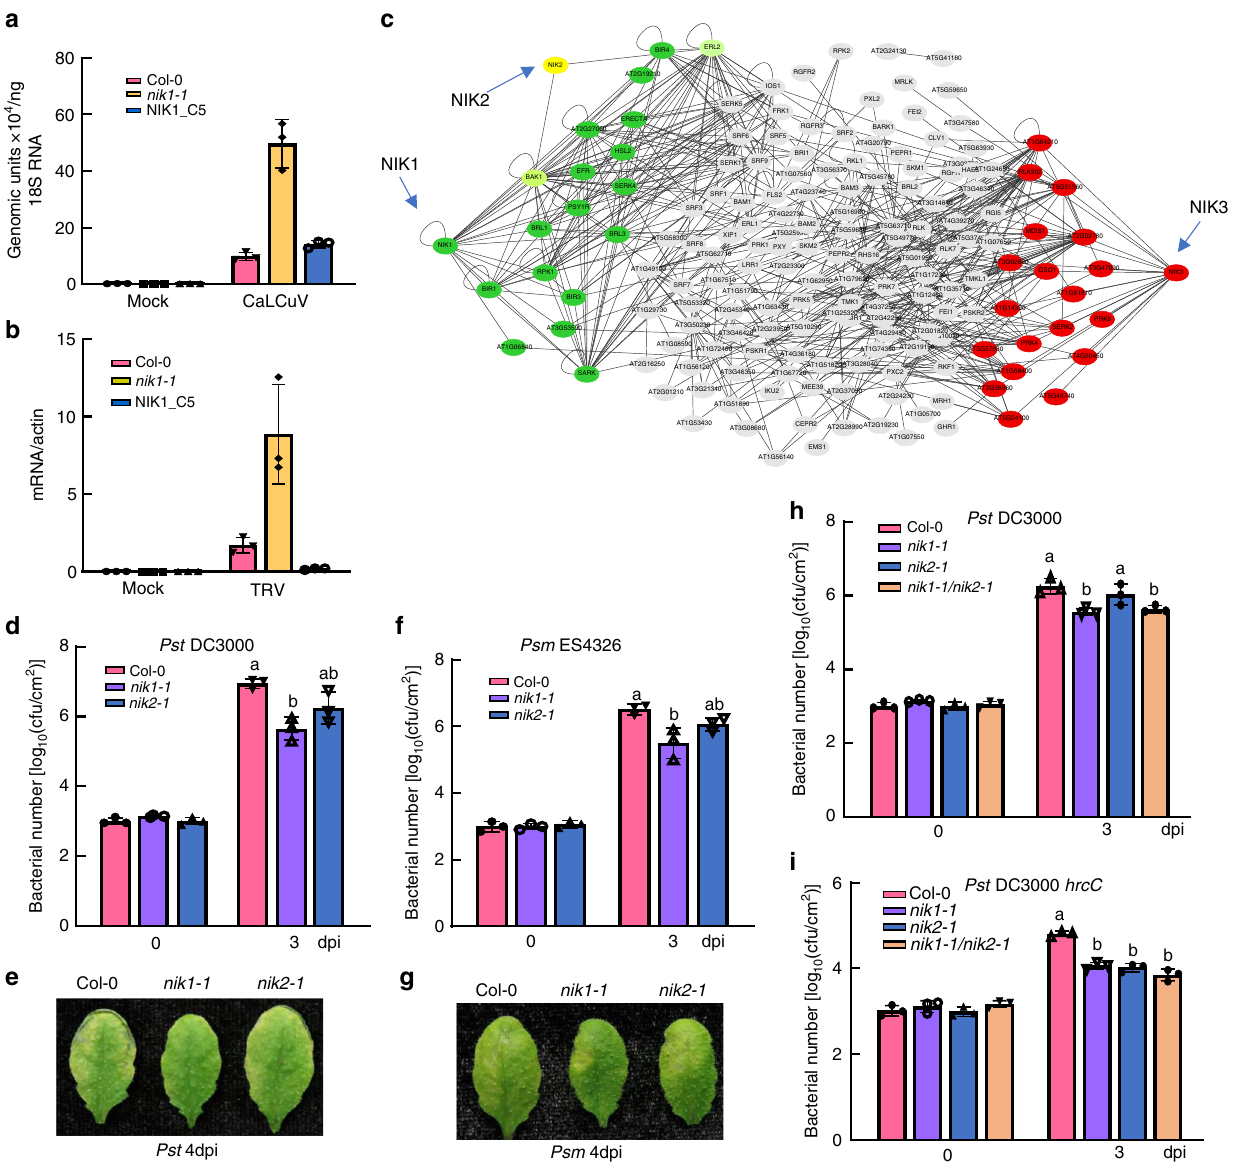
Fig. 1 Opposite roles of NIK1 in resistance to viral and bacterial pathogens. a Quanti fi cation of CaLCuV genomic units in infected plants and mock- inoculated plants. Col-0, nik1-1 and NIK1_C5 plants were inoculated with infectious CaLCuV DNA-A and DNA-B clones by biolistic delivery and viral DNA accumulation was determined by qPCR at 14 dpi using 18S rDNA as endogenous control. b Relative accumulation of TRV in infected and mock-inoculated plants. TRV from N. benthamiana- infected leaves was sap inoculated to Arabidopsis leaves and TRV expression was monitored by qRT-PCR. Error bars,